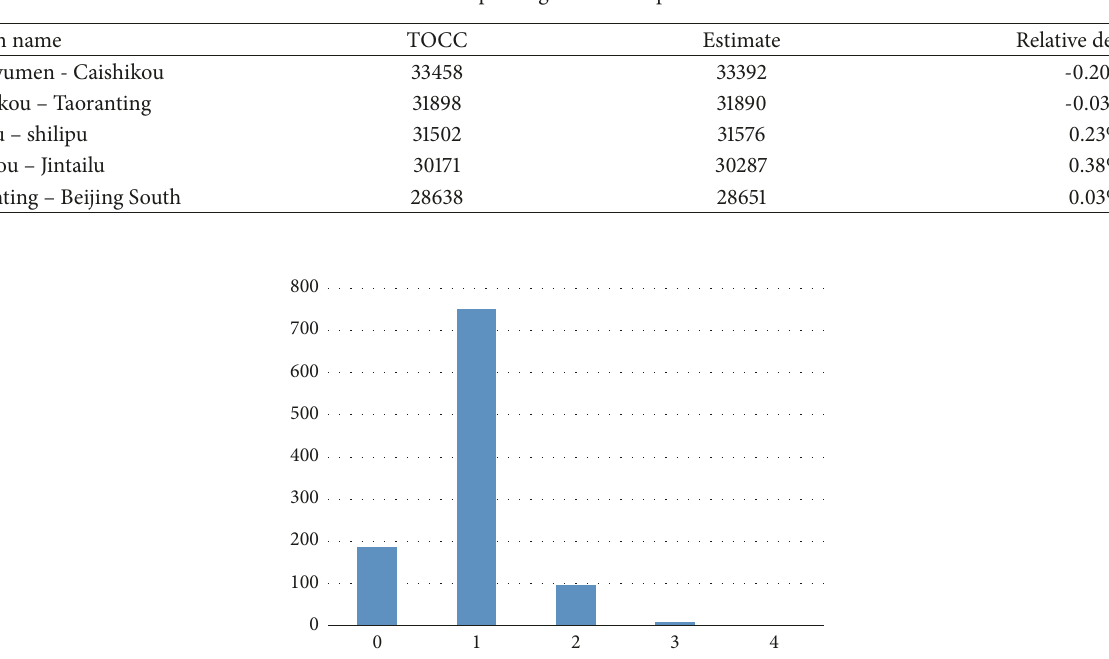
Table 8: Section passenger-flow comparison results.